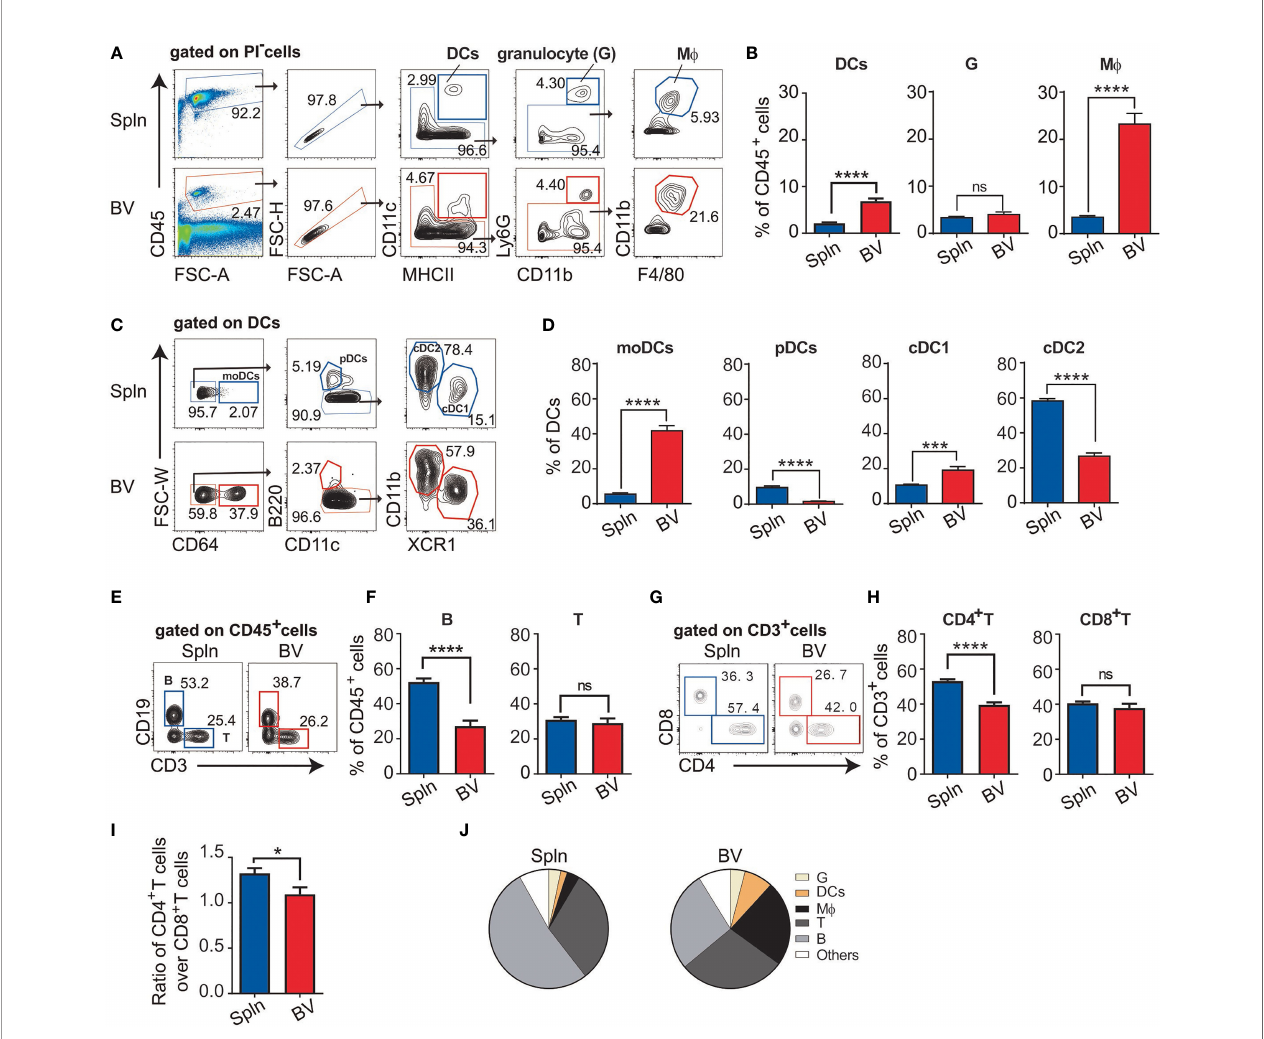
FIGURE 1 | Pro fi le of immune cell composition in vascular tissues. Cell suspensions from aortic blood vascular tissues (BV) and spleens (Spln) of healthy/ nonin fl amed C57BL/6 mice were stained with indicated Abs for FACS analysis. Plots and graphs showed the gating strategy (A) and the proportion (B) of DCs, granulocytes, and macrophages; the gating strategy (C) and the proportion (D) of DC subsets; the gating strategy (E) and the proportion of B and T cells (F) ; and the gating strategy (G) and the proportion (H) of T cell subsets, as well as the ratio (I) of CD4 + T cells over CD8 + T cells in BV and Spln. (J) Pie charts showing the proportion of different immune cells in BV and Spln. Shown here are representative plots of at least three independent experiments performed. The data are shown as mean ± SEM ( n = 6 – 43 mice) and analyzed using Student ’ s t -test. * p < 0.05; *** p < 0.001; **** p < 0.0001. ns, no signi fi cant